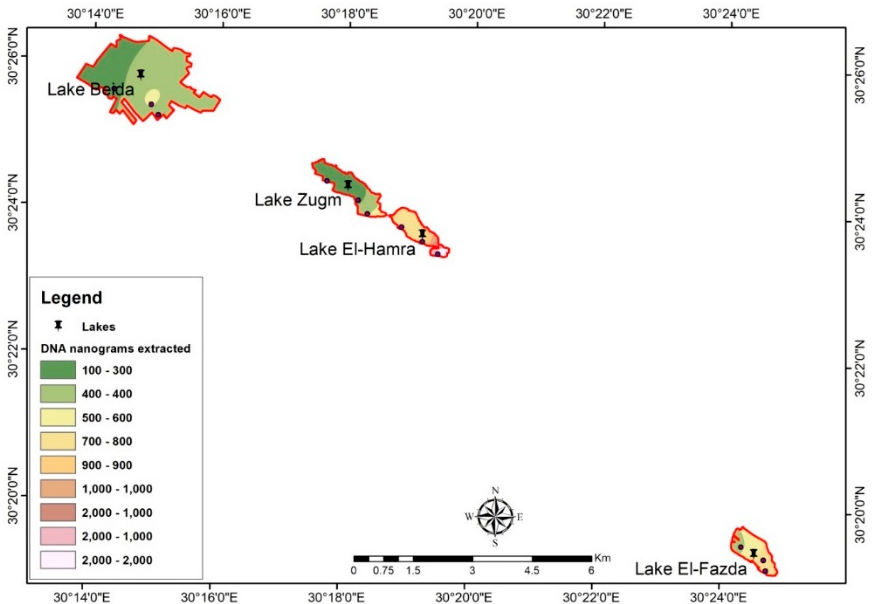
Figure 6. Spatial distribution by GIS of total DNA (ng) extracted from soda lakes of Wadi El-Natrun.